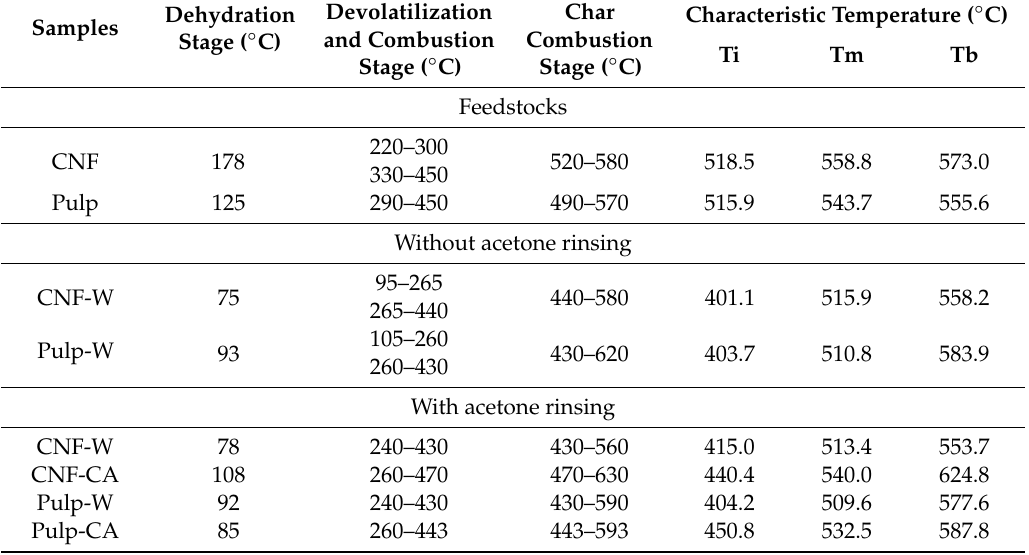
Table 2. Thermogravimetric analysis of feedstocks and hydrochars.